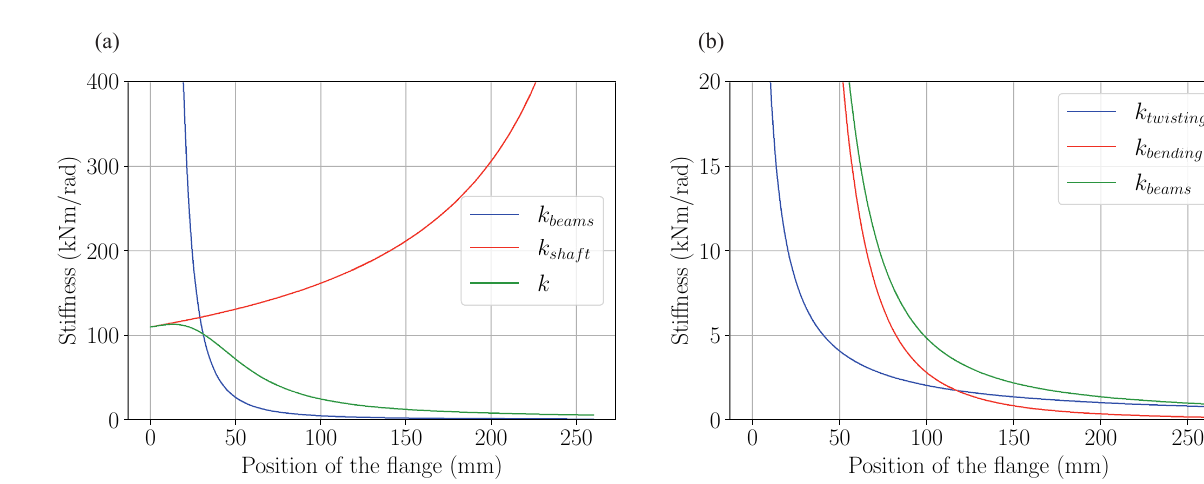
Graph of the shaft stiffness, stiffness of the beams, and stiffness Graph of the stiffness of the beams divided into stiffness against of the coupling. It presents how the stiffness of the shaft and the bending and against twisting. The graph demonstrates how the beams affect the stiffness of the coupling. total stiffness of the beams is Fig. 6. Graphs demonstrating the formation of total torsional stiffness of the coupling.